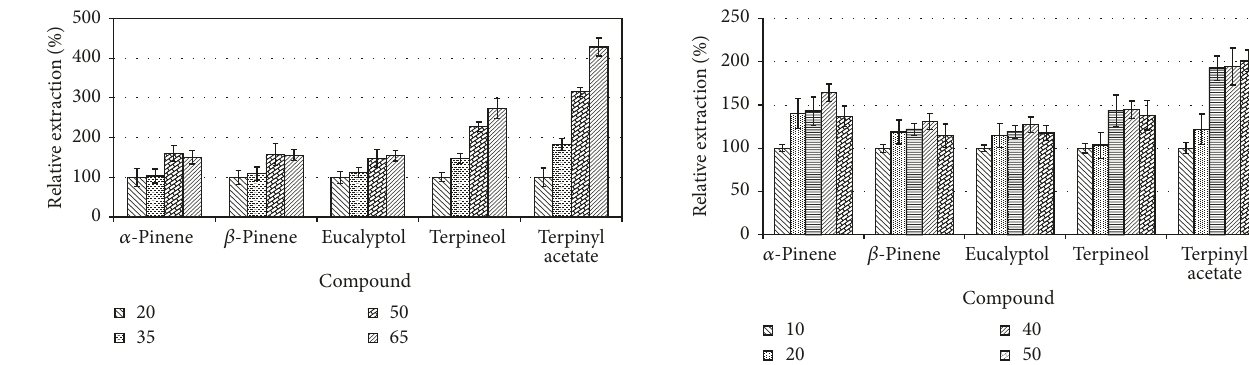
Figure 3: The effect of varying temperature on the extraction of volatiles from A. danielli seeds.